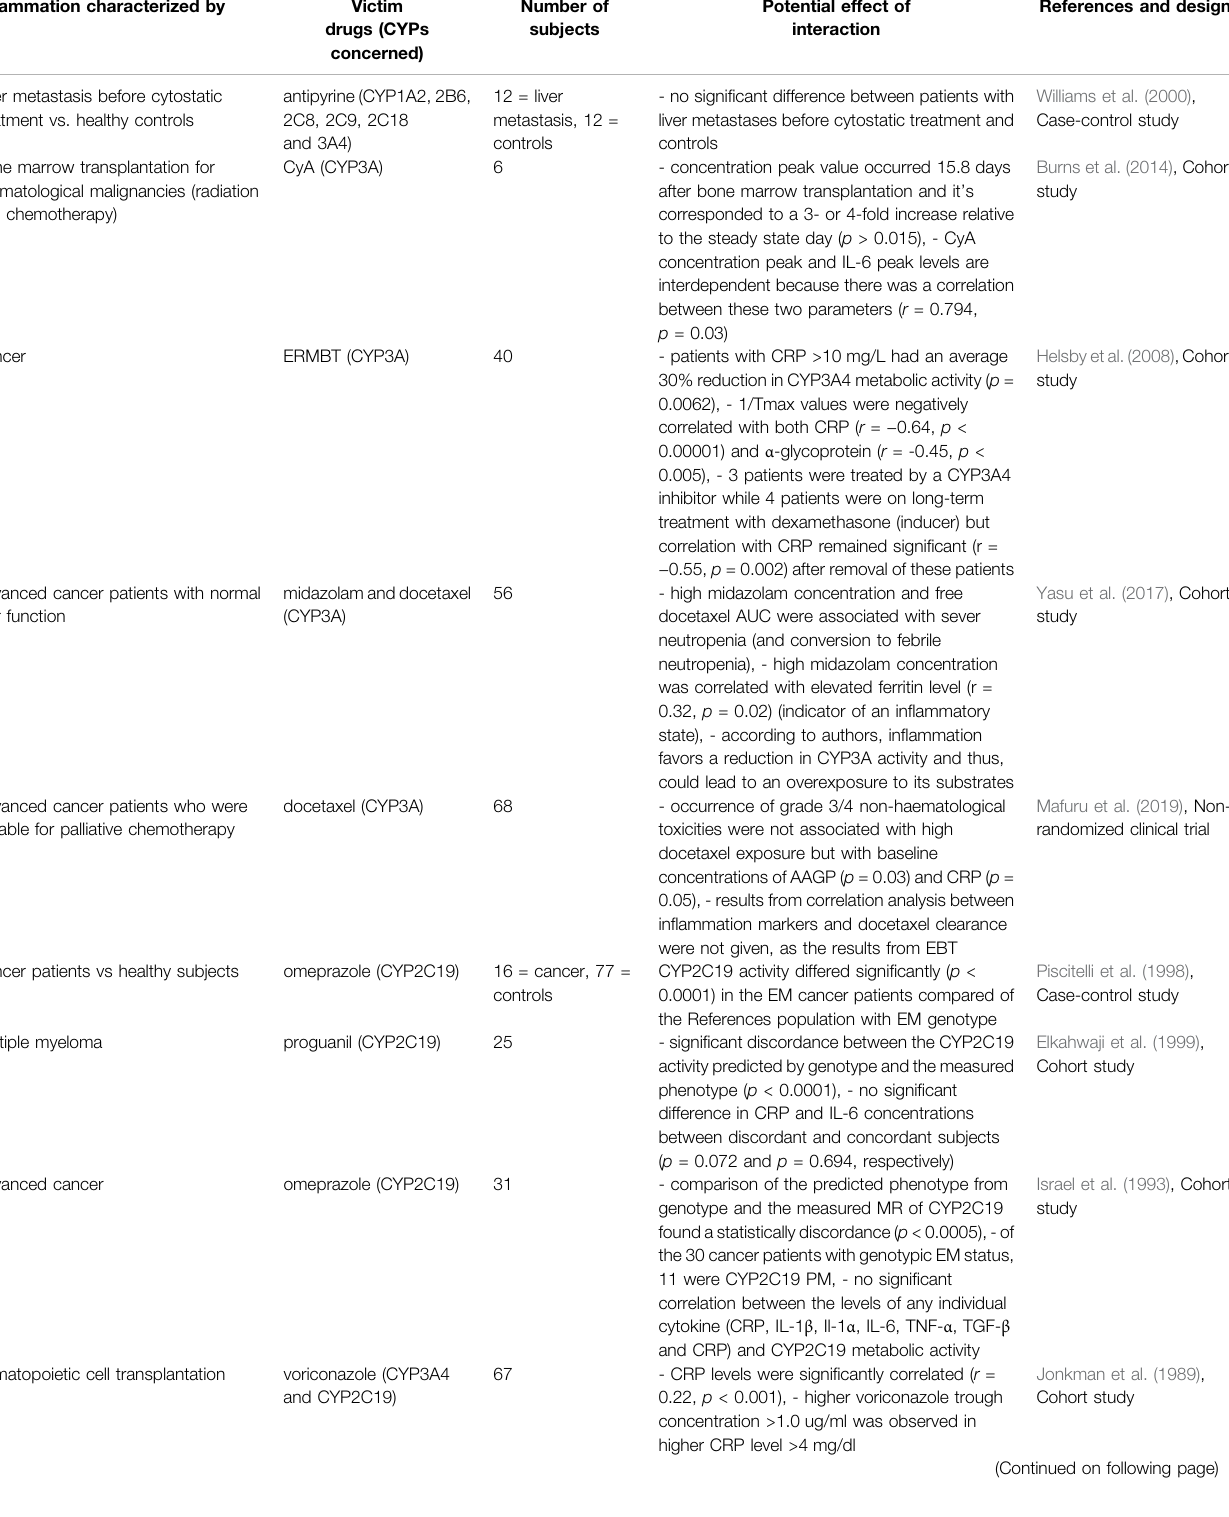
TABLE 12 | Impact of cancer on CYP substrates, explained totally or partially by modulation of CYP activity. In fl ammation characterized